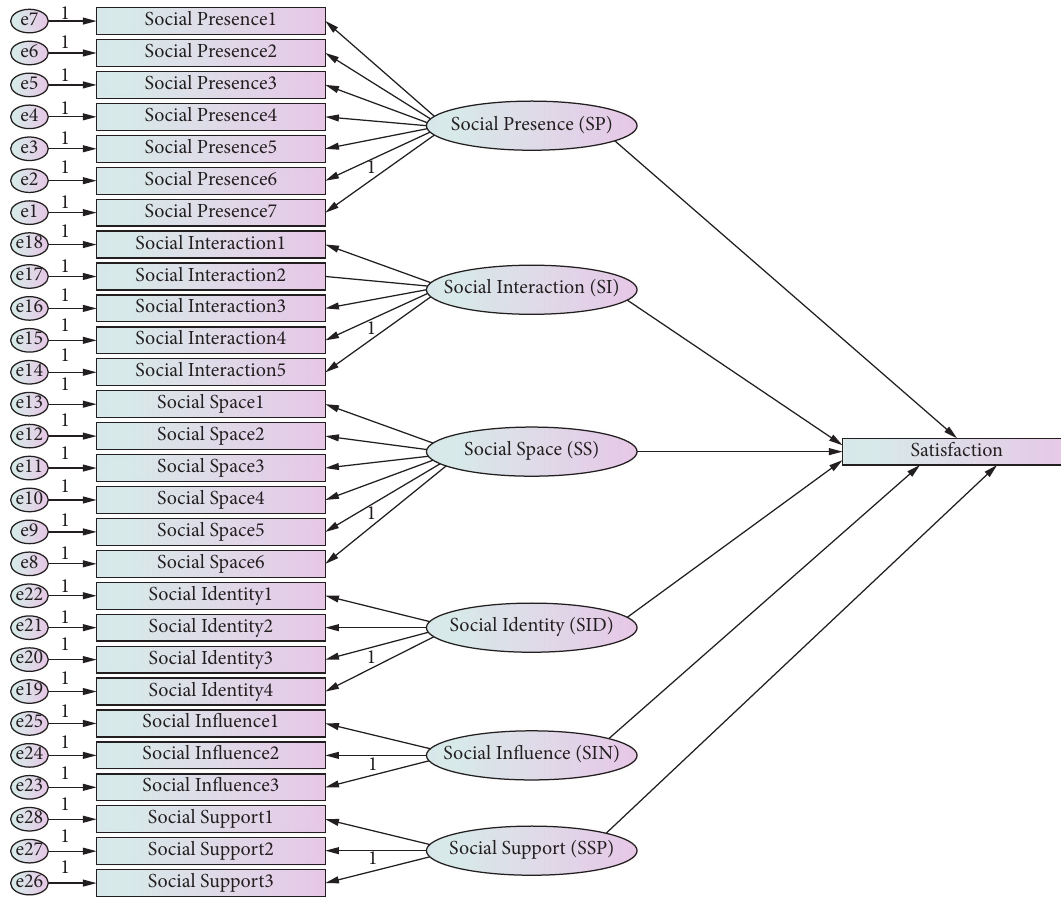
Figure 1: Proposed research Table 1: Research factors, items, and adapted sources. Table 2: The frequency and percentage of the respondents’ profiles.